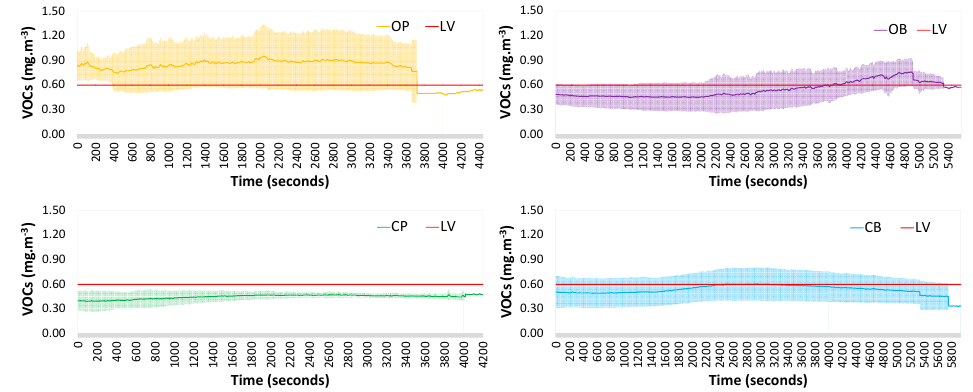
Figure 8. Temporal variability of VOCs (line—mean; light coloured area—standard deviation) during the combustion period for the four studied conditions: ( top , left ) OP—open fireplace and pinewood, ( top , right ) OB—open fireplace and briquettes, ( bottom , left ) CP—closed fireplace (insert) and pinewood, and ( bottom , right ) CB—closed fireplace (insert) and briquettes. The red line represents the VOC limit value of 0.6 mg·m − 3 defined by the Portuguese legislation [32].